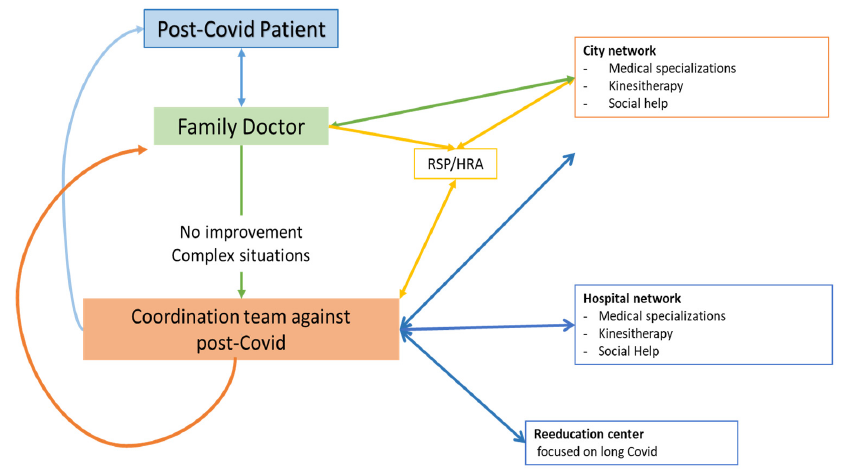
Figure 1. Structuration of post-COVID patients’ support. RSP: Regional Support Platform. HRA: Health Regional Agency.